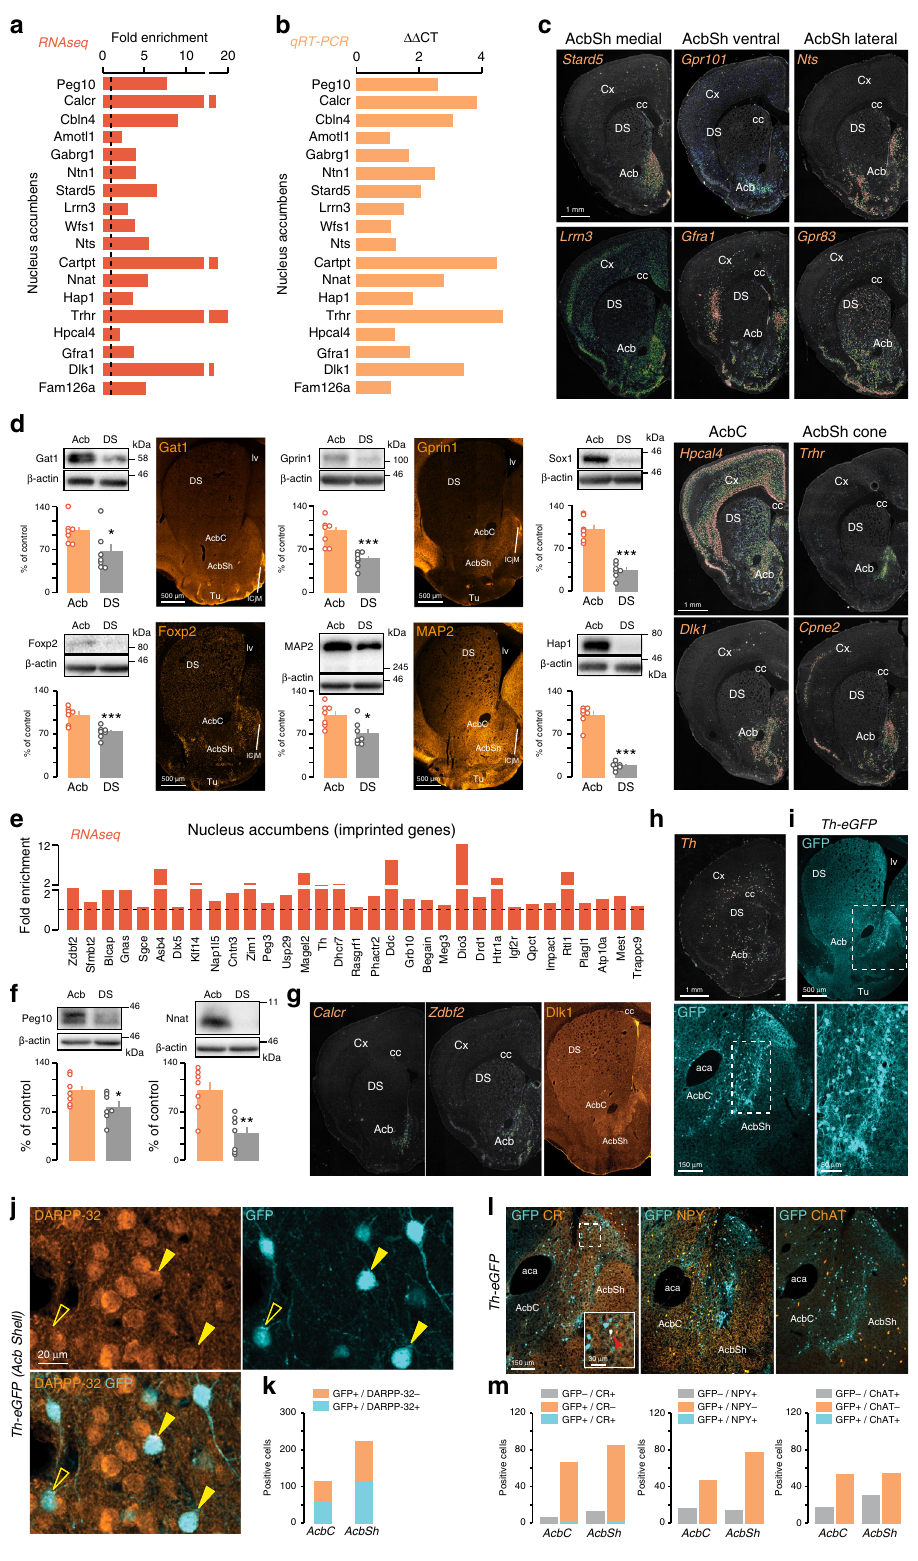
on neurotransmitter systems as well as GO analysis suggested major differences between Acb WFS1 and D2R neurons (Supplementary Figs. 8 and 9 and Supplementary Data 9). Indeed, a bias toward the Acb D2R neurons is particularly evident for subunits of voltage-gated calcium channels, sodium channels, and voltage-gated potassium channels (Supplementary Fig. 9a,